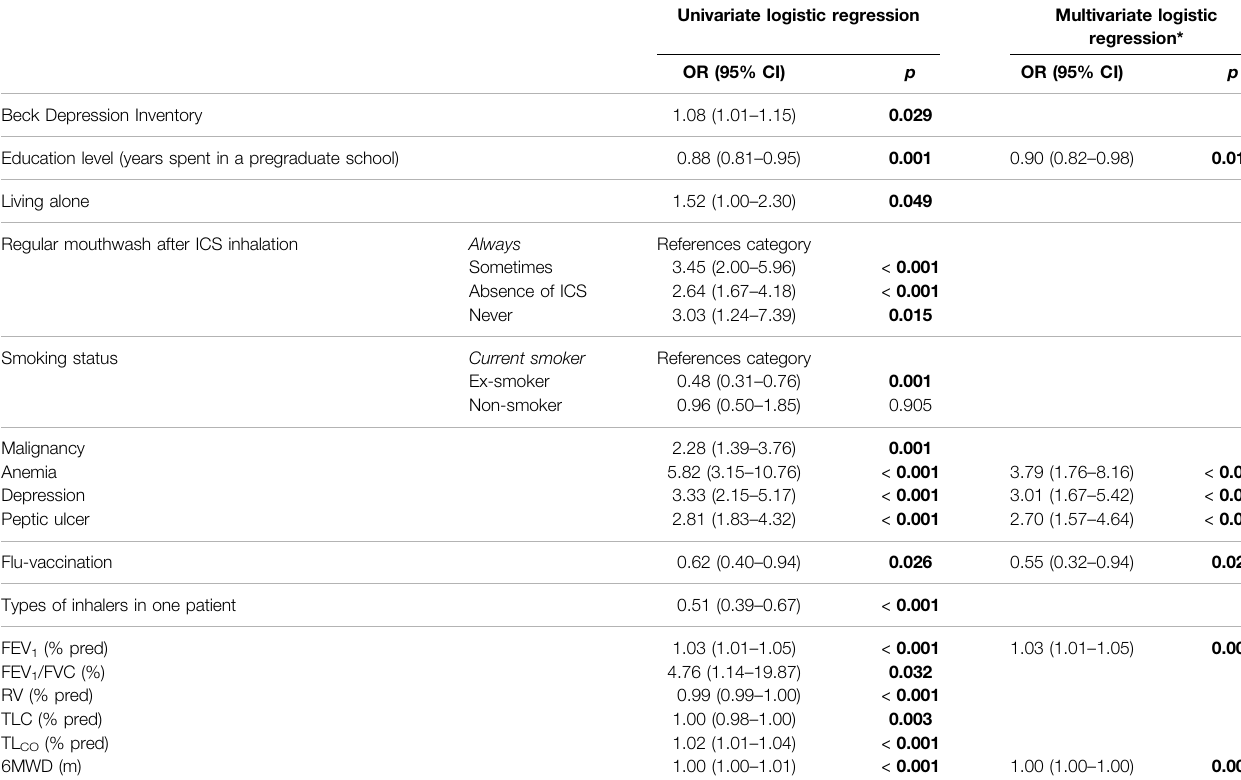
TABLE 2 | Independent predictors of suboptimal overall adherence (Morisky Medication Adherence Scale ©MMAS-4 >